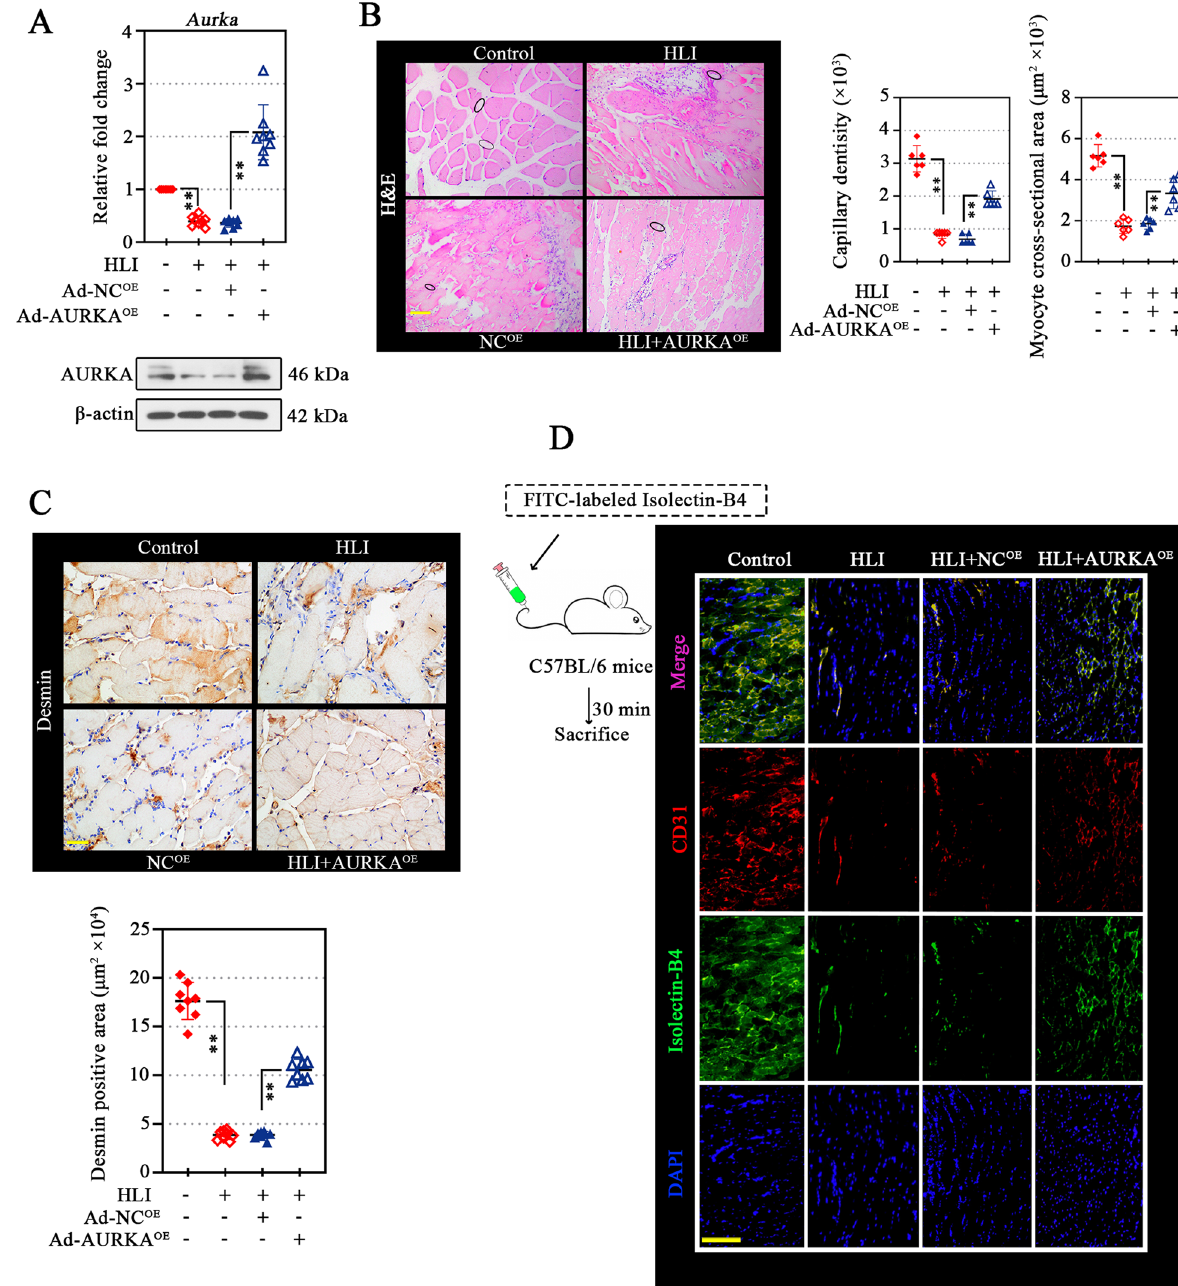
Fig. 7 AURKA overexpression protects muscle against diabetic ischemia injury. After 21 days of modeling, the AURKA mRNA (bar graph) and protein (bands) levels in gastrocnemius muscle tissues from all experimental groups were validated ( A ). Pathologic changes in gastrocnemius muscle tissues were evaluated using H&E staining ( B , left), and the capillary density and myofiber cross-sectional area were determined ( B , right). The black circle indicated capillaries. Scale bar, 100 μm ( B ). Immunohistochemistry (IHC) staining of Desmin on gastrocnemius muscle tissues to visualize muscle regeneration ( C , upper), and the Desmin + area was measures ( C , lower). Scale bar, 50 μm. FITC-labeled Isolectin-B4 (50 μL) was injected via tail vein thirty minute before the mice were sacrificed. Identification of perfused blood vessels and capillaries in the gastrocnemius muscle was observed by dual immunofluorescence with Isolectin-B4 and CD31. Scale bar, 200 μm ( D ). Data were represented as mean SD. ± ** P < 0.01. Each dot indicated a biological replicate, n =